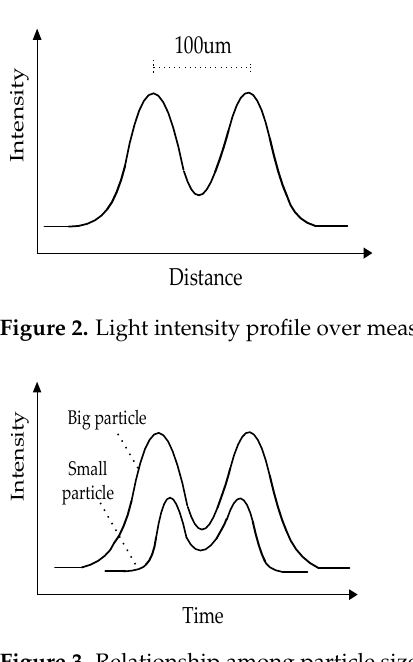
Figure 3. Relationship among particle size, TOF, and intensity.